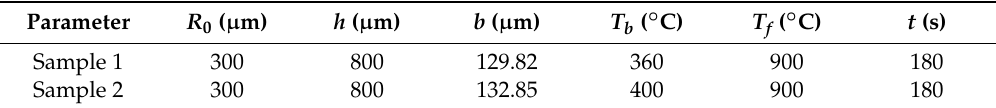
Table 1. The experimental parameters of the two samples